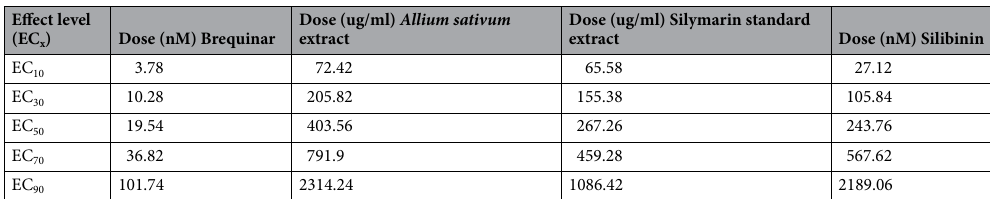
Table 8. Illustrative table demonstrating the tested data points of Allium sativum, silymarin standard extract and silibinin samples conducted in combination analysis at five dose levels. EC 10 , EC 30, EC 50 , EC 70 and EC 90 , are the concentrations of each individual sample required to inhibit hDHODH enzyme at 10, 30, 50, 70 and 90%,